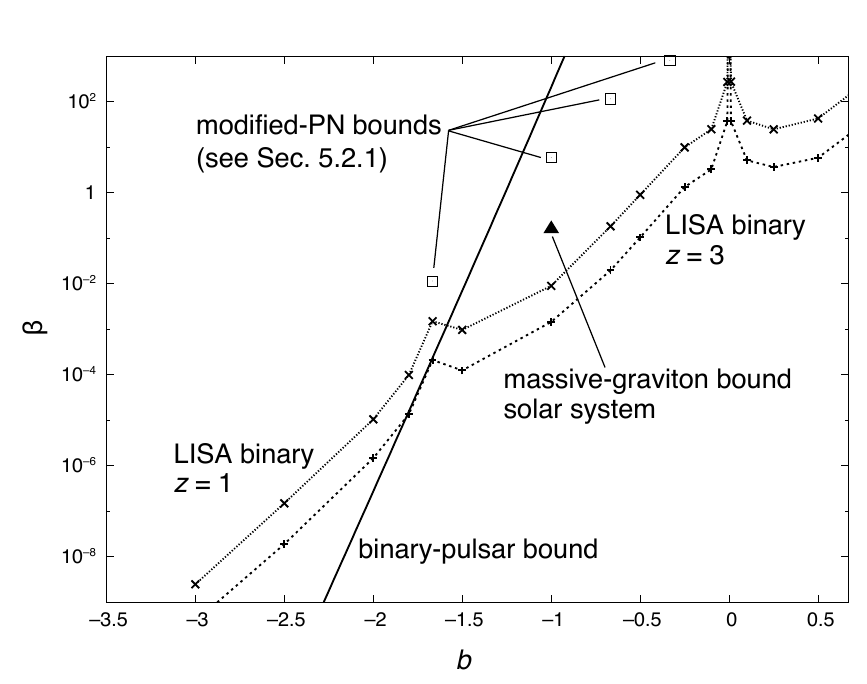
Figure 6: Constraints on phasing corrections in the ppE framework, as determined from LISA observations of ∼ 10 6 𝑀 ⊙ massive–black-hole inspirals at 𝑧 = 1 and 𝑧 = 3. The figure also includes the 𝛽 bounds derived from pulsar PSR J0737–3039 [492], the solar-system bound on the graviton mass [435], and PN-coefficient bounds derived as described Section 5.2.1. The spike at 𝑏 = 0 corresponds to the degeneracy between the ppE correction and the initial GW-phase parameter. (Adapted from